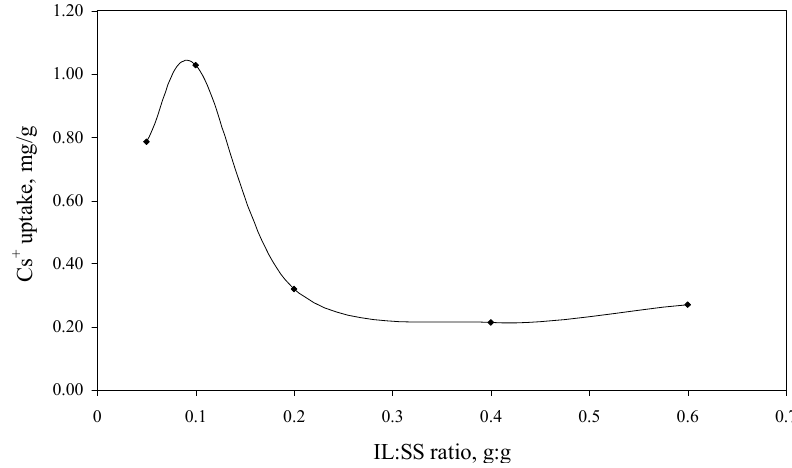
Figure 1. The dependence of the Cs + uptake versus of IL:SS ratio (C t = 2 h, pH = 8, m = 0.1 g).